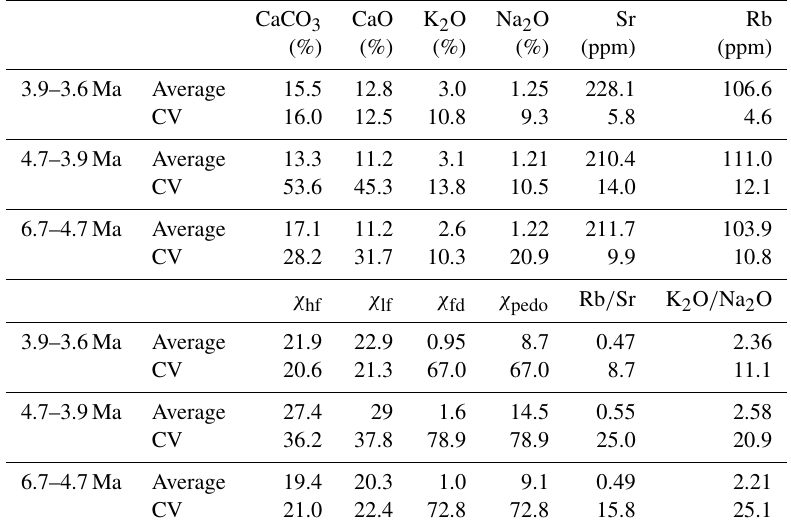
Table 1. Average values and coefficients of variation of the geophysical and geochemical data for the XSZ section. CaCO 3